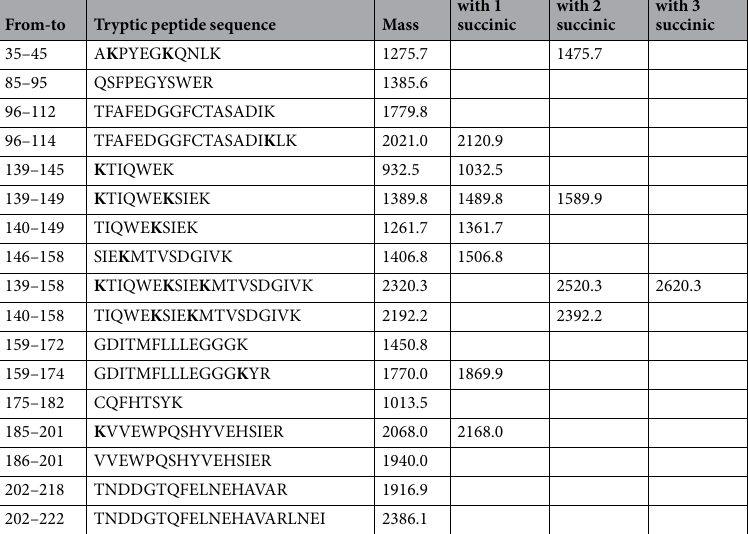
Table 1. Amino acid sequences of modified tryptic peptides identified by MALDI-TOF/TOF. Masses are given in Daltons.